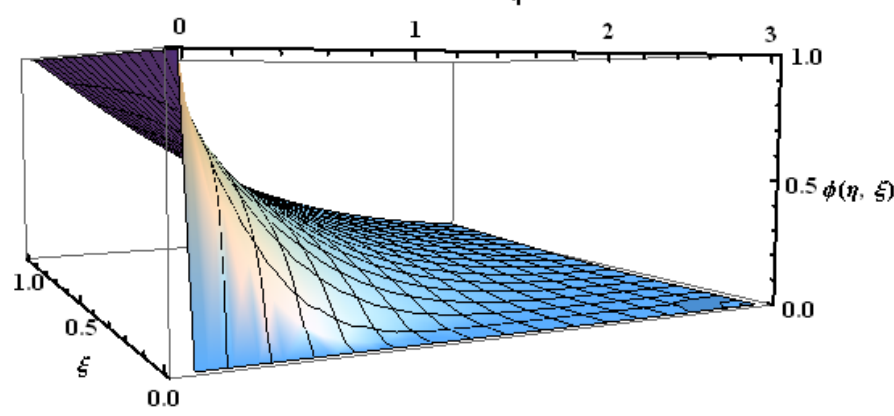
Figure 4. Surface of φ ( ξ , η ) for ξ ∈ [ 0,1 ] and for η ∈ [ 0, ∞ ]